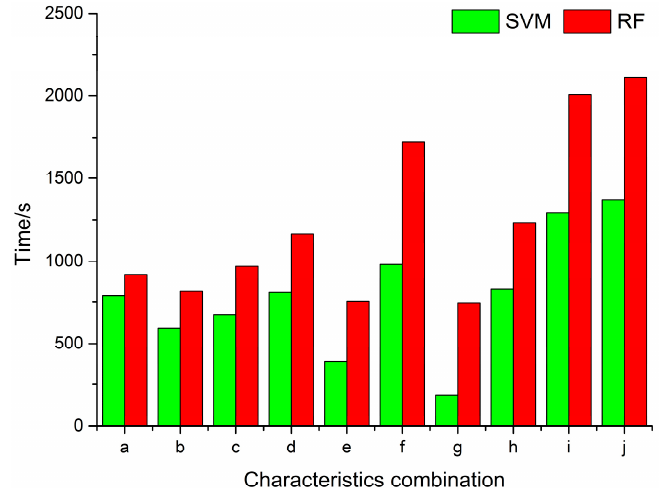
Figure 5. Comparison of processing time of different combinations classification by RF and SVM algorithms.